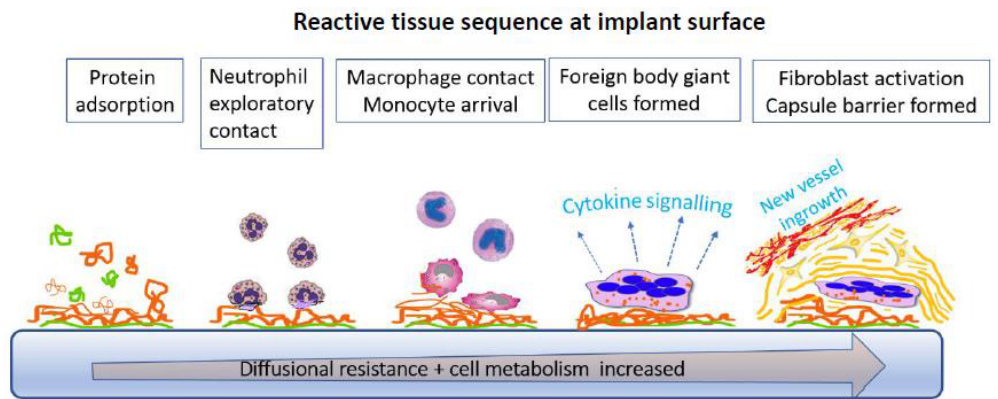
Figure 9. Schematic of tissue foreign body response in sequence: ( 1 ) Rapid protein deposition masks sensor surface; deposited layer increases. ( 2 ) Tissue neutrophils sense the surface and send chemotactic signals, mast cells promote inflammatory background. ( 3 ) Macrophages accumulate with population reinforcement by blood monocytes. ( 4 ) Failure to degrade surface stimulates more powerful multinucleated giant cell formation from macrophages, with enhanced signalling. ( 5 ) End stage of more quiescent collagen formation and cumulative barrier formation by fibroblasts with parallel neovasularisation.